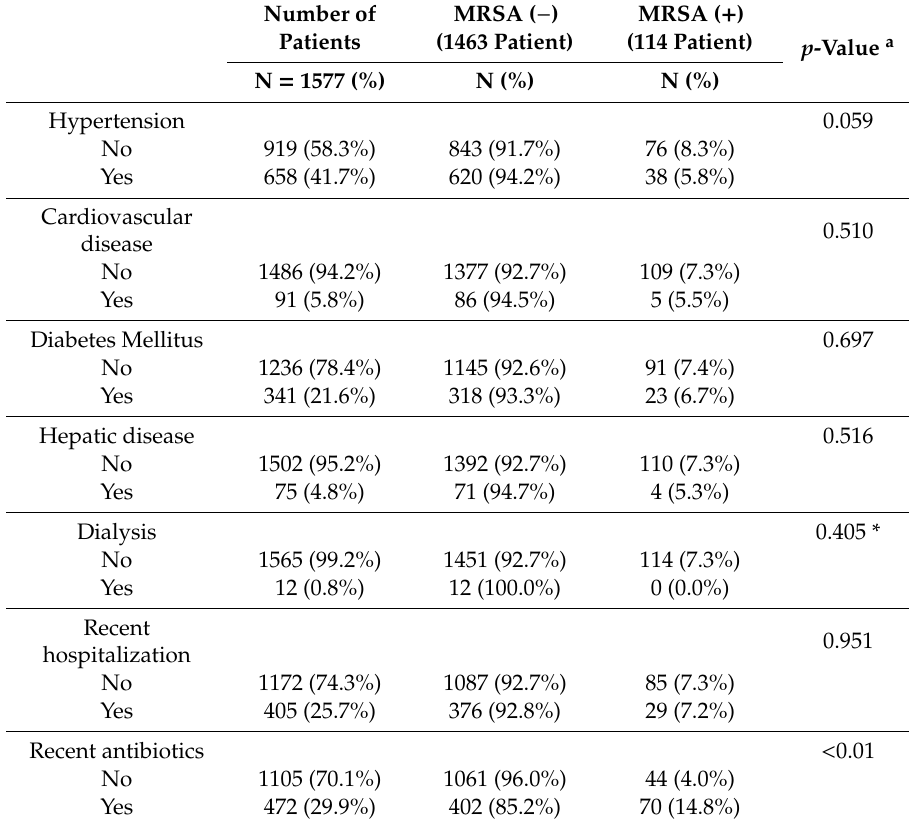
Table 3. Descriptive logistic regression analysis from data obtained at admission (medical comorbidities, other risk factors for